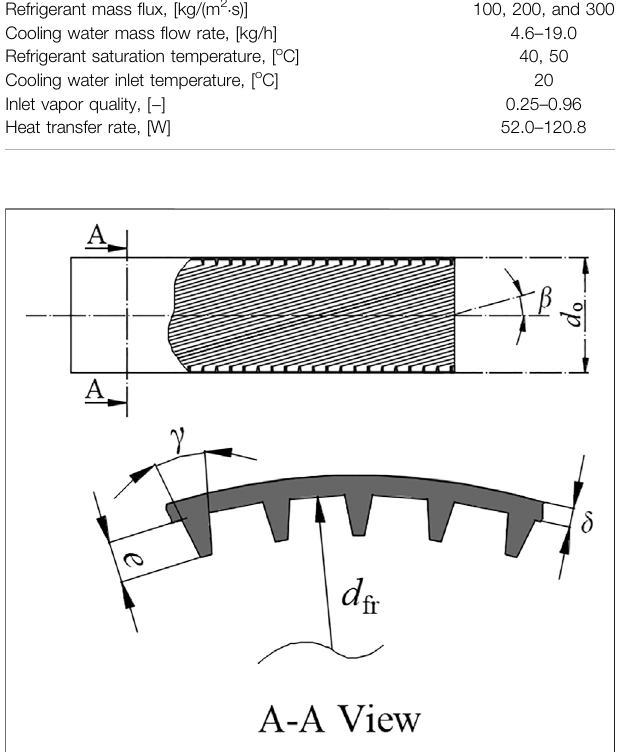
FIGURE 3 | Geometrical parameters of the micro- fi n